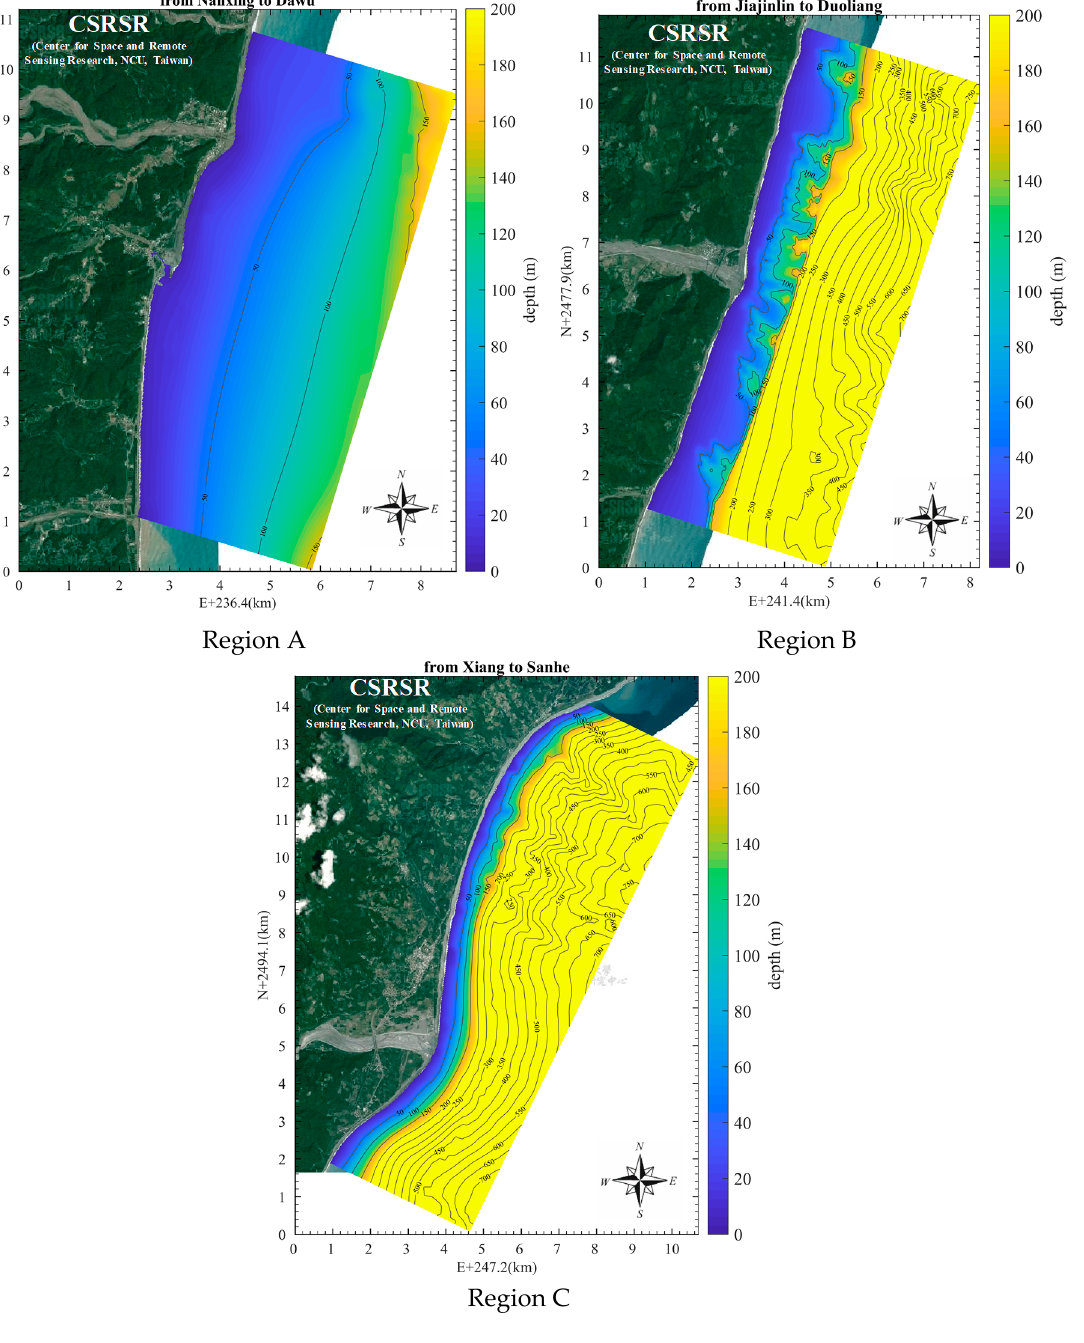
Figure 11. Bathymetry for near-field simulation.